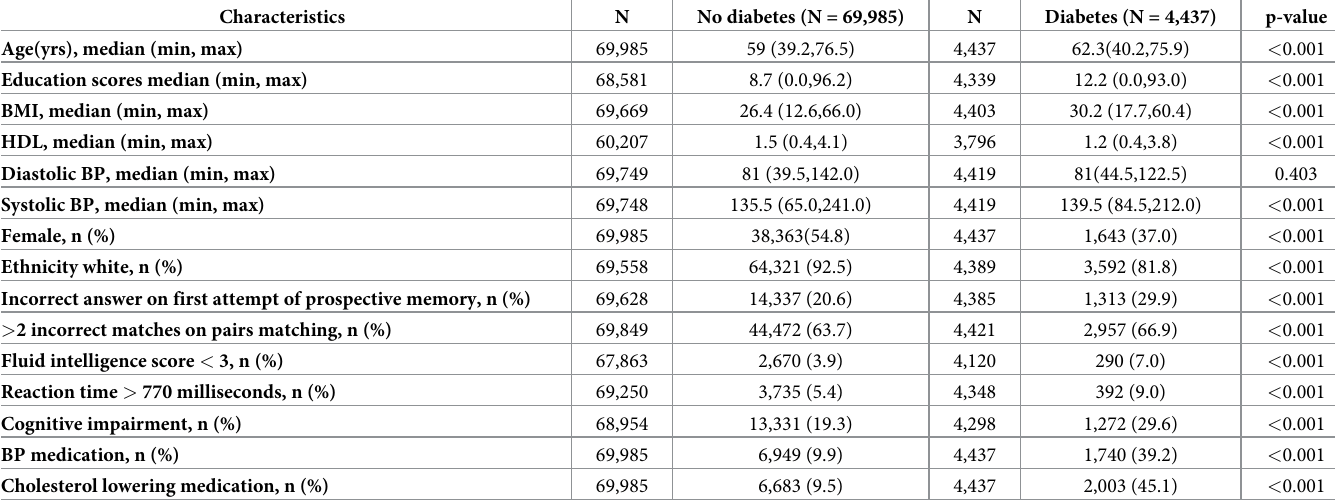
Of the 74,422 participants included in the study: 69,985 did not have DM and 4,437 had DM. Participants with DM were older (median 62.3 years vs 59 years, p < 0.001), more likely to be men (63.0% vs 45.2%, p < 0.001), more likely to be on cholesterol lowering (45.1% vs 9.5%, p < 0.001) or blood pressure lowering medications (39.2% vs 9.9%, p < 0.001), and more likely to have impairment on cognitive testing (29.6% vs 19.3%, p < 0.001) compared to those without DM (See Tables 1and 2). Participants with DM had on average lower total retinal thickness (4.57 μ m lower, 95% CI: -5.00, -4.14; p < 0.001), GC-IPL thickness (1.73 μ m lower, 95% CI: -1.86, -1.59; p < 0.001) and mRNFL thickness (0.68 μ m lower, 95% CI: -0.81, -0.54; p < 0.001) compared to those without DM. A full list of the associations with total retinal thickness, mRNFL and GC-IPL thickness measures are shown in S3 Table. Systolic blood pressure and diastolic blood pressure were correlated and use of cholesterol lowering and blood-pressure lowering medications were correlated. To avoid collinearity, we chose systolic blood pressure and cholesterol lowering medication for the multivariable GLMM. After adjusting for co-variates in the multivariable GLMM (See Table 3), total retinal thick- ness was 1.99 um thinner (95% CI: -2.47–1.50, p < 0.001) among participants with diabetes compared to those without DM, and GC-IPL was 1.02 um lower (95% CI: -1.18, -0.87; p < 0.001) among those with diabetes compared to those without. The difference in mRNFL thickness was no longer significantly different (p = 0.369). Fig 1A–1C show the adjusted differ- ences in average retinal thickness measurements after controlling for co-variates among partic- ipants with and without DM for total retinal thickness (Fig 1A), mRNFL (Fig 1B) and GC-IPL Table 1. Patient summary statistics stratified by diabetes (all included patients).